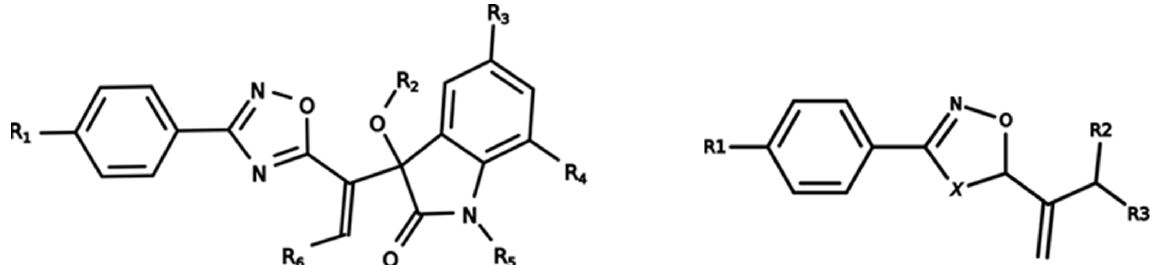
Figure 1. General scaffold of group G 1 ( left ) and group G 2 ( right ).